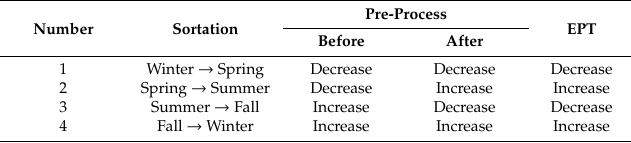
Table 10. Comparison of prediction results between preprocessing and non-preprocessing of variables.